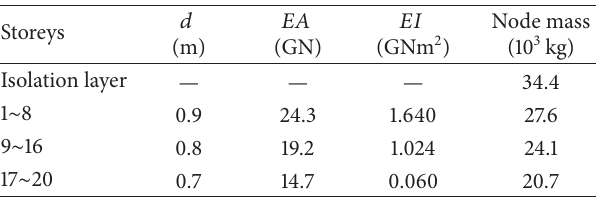
Table 1: Properties of columns for the 20-storey building and mass distribution for each storey.